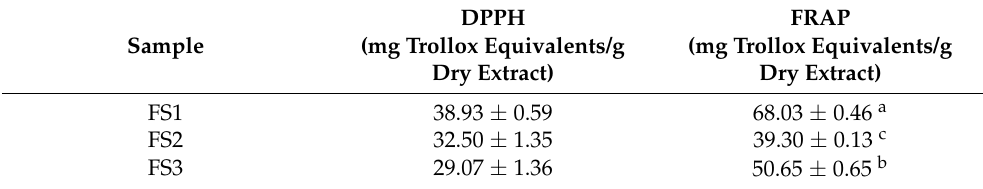
Table 4. Results for the antioxidant activity assays for the tested F. schleicheri samples.